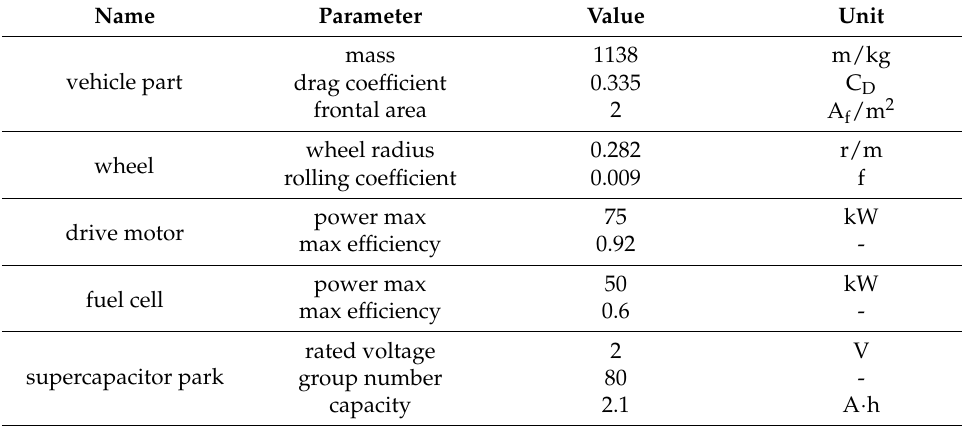
Figure 1. Powertrain structure of FCHEV. Table 1. The vehicle’s primary technical parameters.